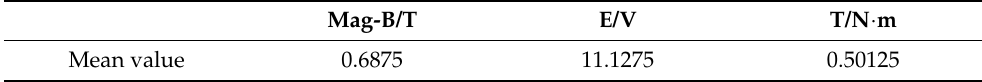
Table 6. Results on the overall average.